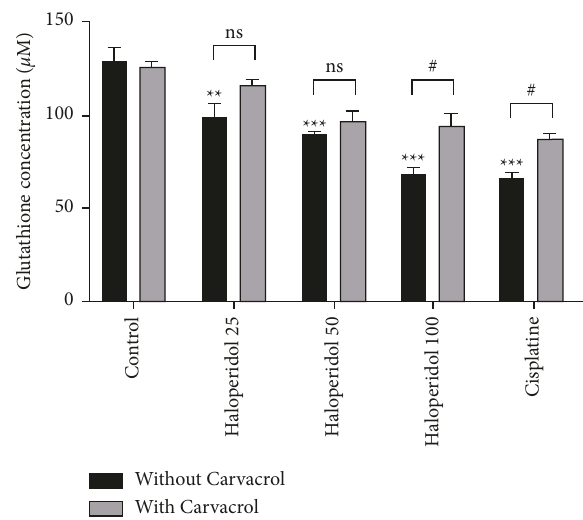
Figure 7: The protective effect of carvacrol on haloperidol-induced glutathione level in human lymphocytes; values are presented as the mean ± SD; ∗∗ significantly different compared to the control group without carvacrol ( P < 0 . 01); ∗∗∗ significantly different compared to the control group without carvacrol ( P < 0 . 001); #significantly different in comparison with the haloperidol-treated group without carvacrol ( P < 0 . 05); ns: not